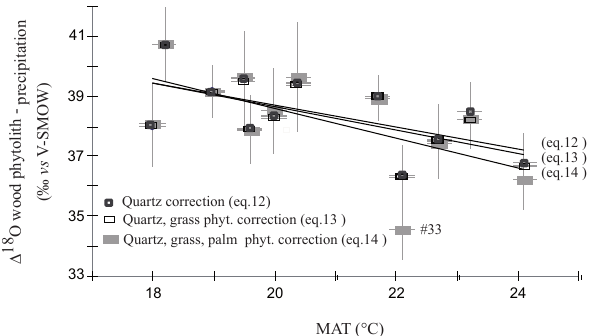
Fig. 6. Impact of non-wood phytolith corrections: relationships be- tween 1 18 O wood phytolith - precipitation value and mean annual atmo- spheric temperature (MAT) obtained for the three windward tran- sects and depending on non-wood phytolith corrections (Table 3). Cf. text for Eqs.